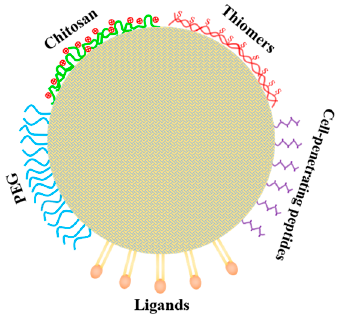
Figure 8. Schematic representation of several types of surface-modified SLNs.